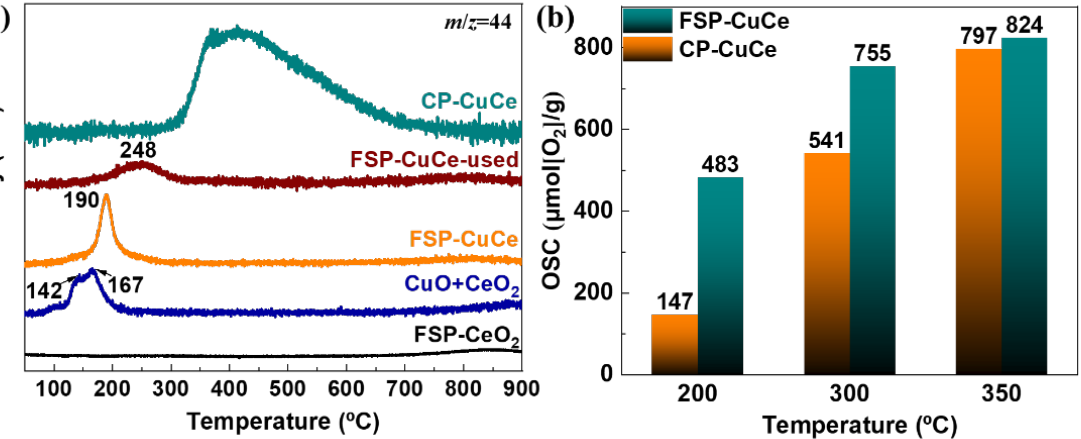
Figure 6. Reduction behavior of Cu and Ce species. ( a ) CO 2 generation ( m / z = 44) profiles during CO-TPR of FSP-CeO 2 , the physical mixture of CuO and CeO 2 powders (CuO + CeO 2 ), FSP-CuCe, used FSP-CuCe and CP-CuCe. ( b ) Oxygen storage capability (OSC) values for FSP-CuCe and CP-CuCe catalysts evaluated at different temperatures.